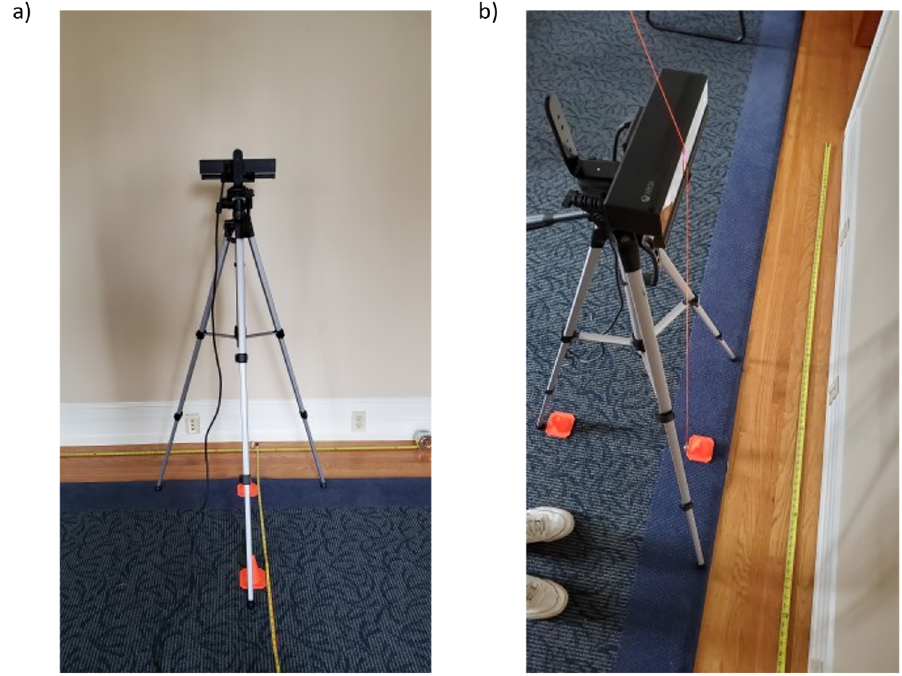
Figure 5. The Kinect v2 ( a ) in the 0.5 m position and ( b ) its positioning using a plumb bob.